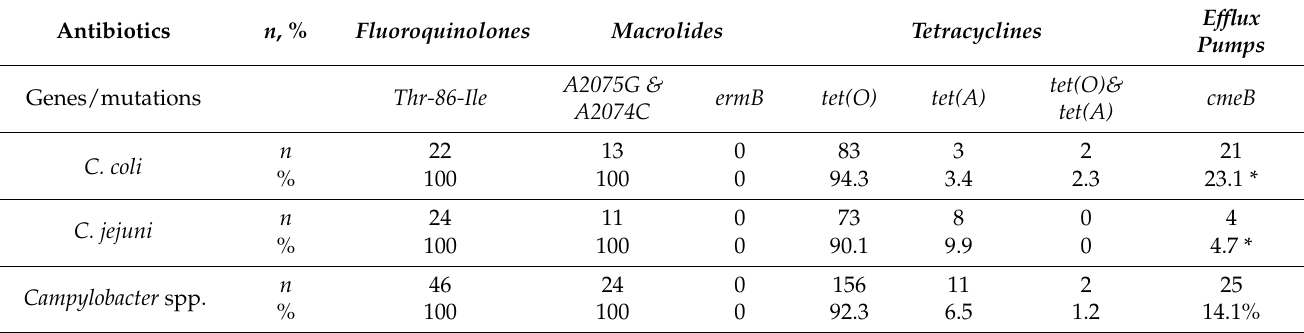
Table 4. Frequency of common mutations and genes conferring resistance to fluoroquinolones, tetracycline, macrolides, and efflux pumps in C. jejuni and C. coli